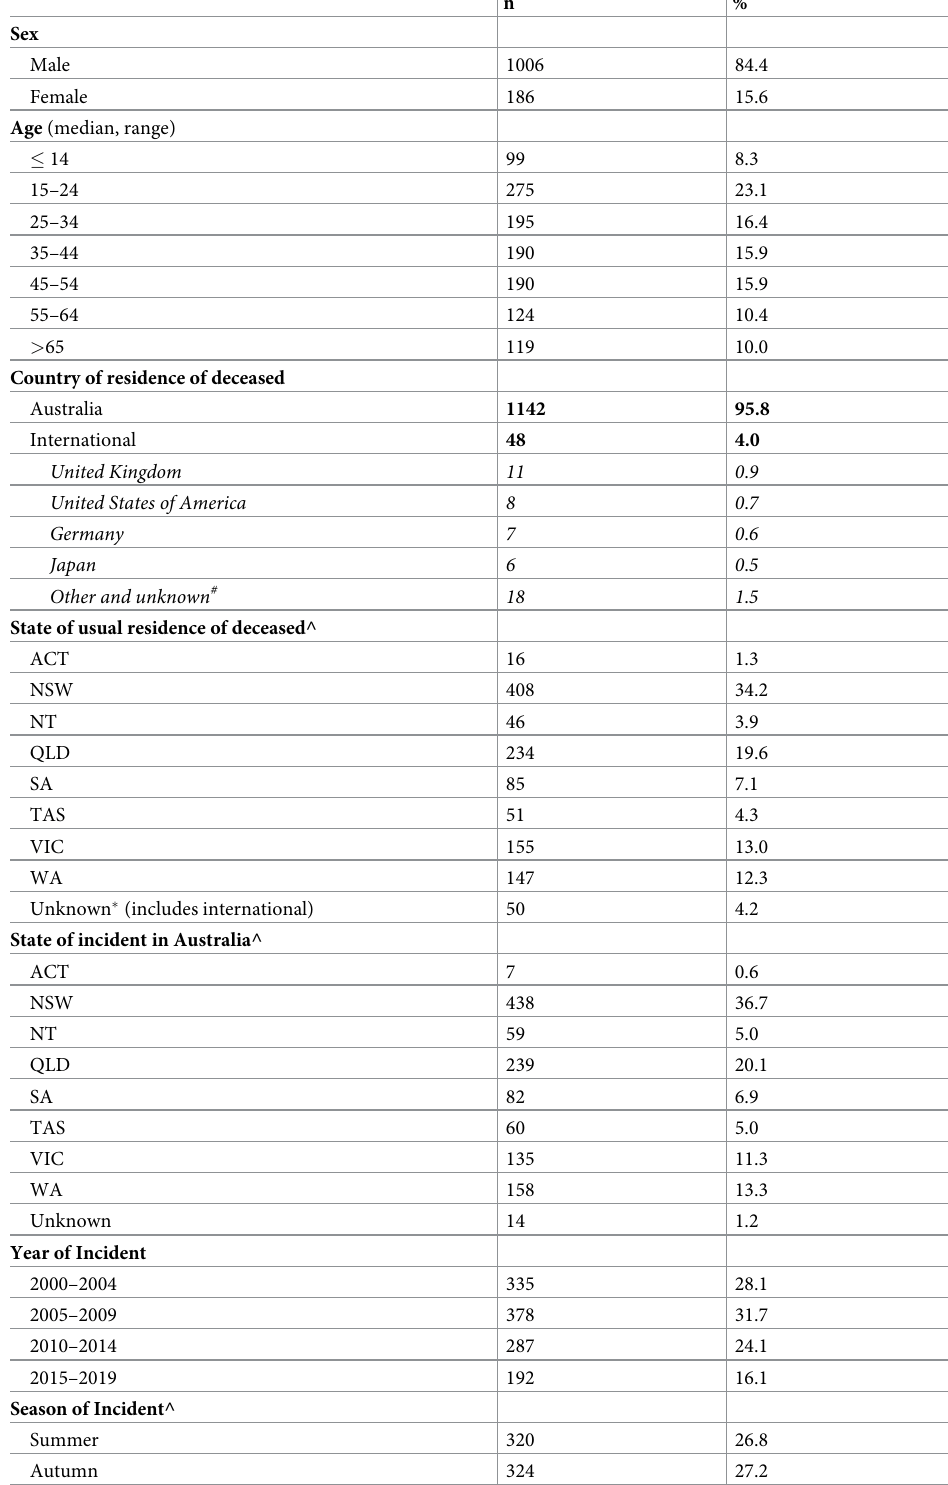
Table 1. Socio-demographic characteristics of sport and active recreation injury deaths in Australia,